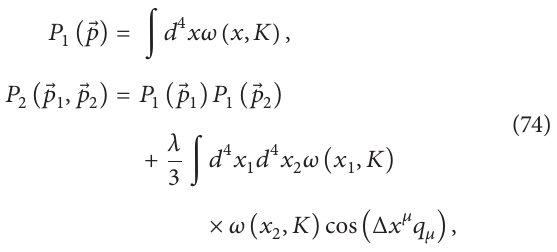
of V 𝑟 at RHIC are larger than those of SPS as expected due to higher initial